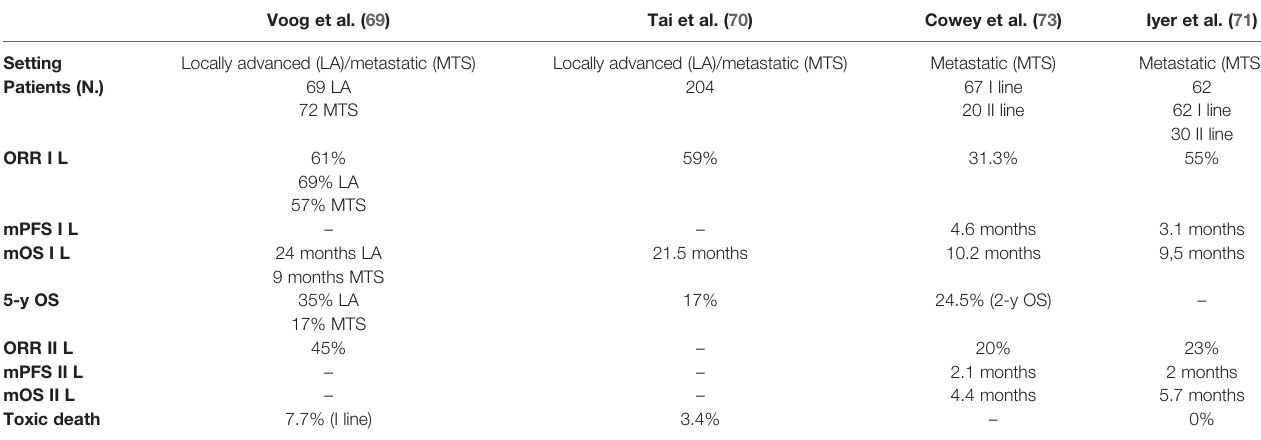
TABLE 1 | Clinical outcomes in selected chemotherapy studies for patients with Merkel cell